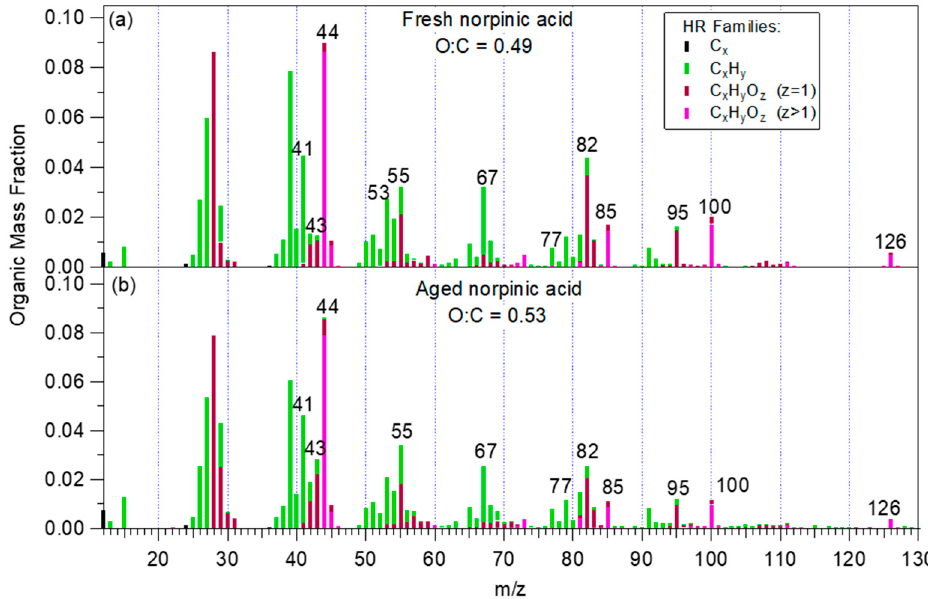
Figure 5. The mass spectrum of the: ( a ) fresh and ( b ) aged norpinic acid aerosol derived from the PMF analysis of the AMS measurements in experiment 2.